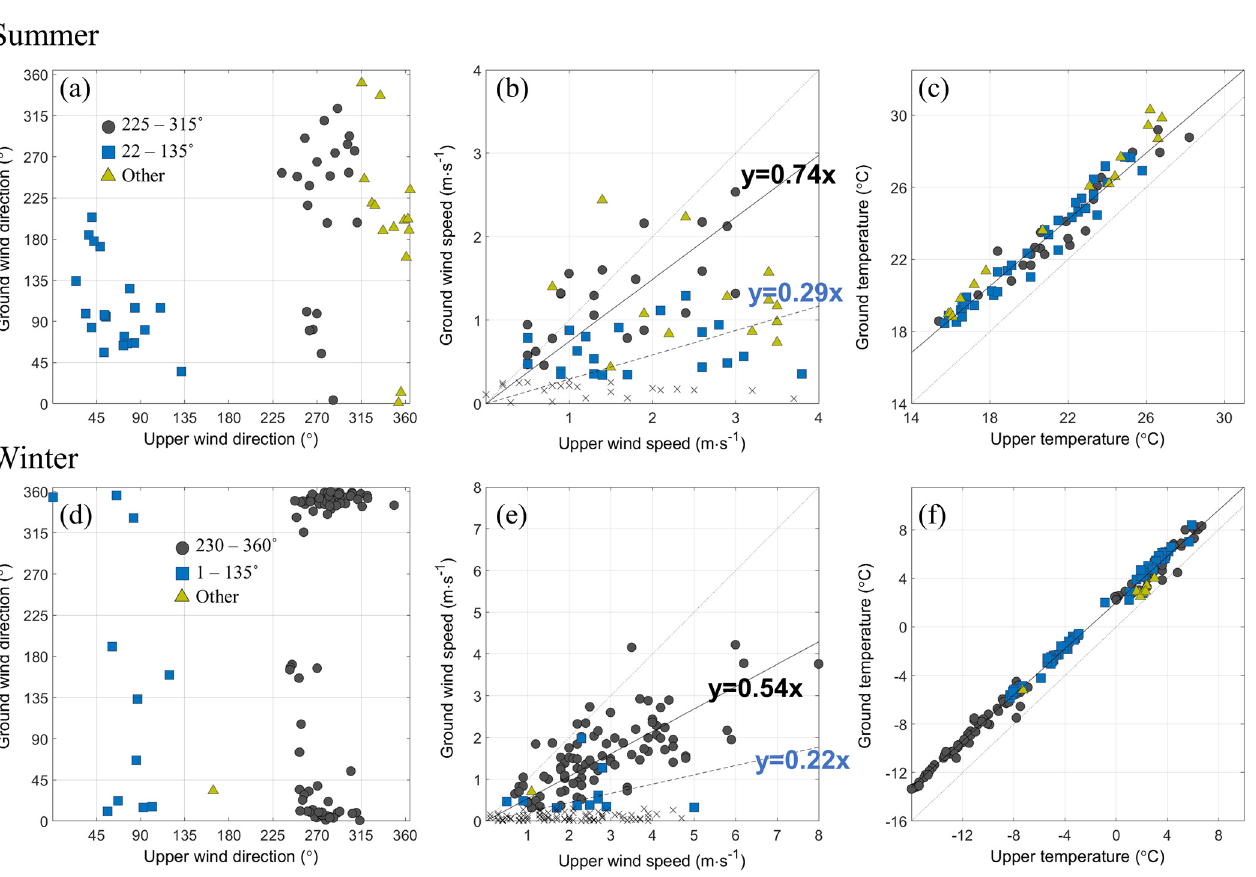
Figure 2. Comparison of the hourly meteorology between the KMA AWS site (prevailing wind) and ground level (Site-1 in summer and Site-2 in winter). ( a , d ) show wind direction, ( b , e ) wind speed, and ( c , f ) the temperature in summer and winter, respectively. Black circles denote westerly prevailing winds, blue squares easterlies, and yellow triangles other directions. The gray x indicates that ground wind speeds were less than 0.3 m·s − 1 (wind direction could not be determined). The black solid and gray dotted lines in ( b , e ) represent the linear fits for the black circles and blue squares, respectively.